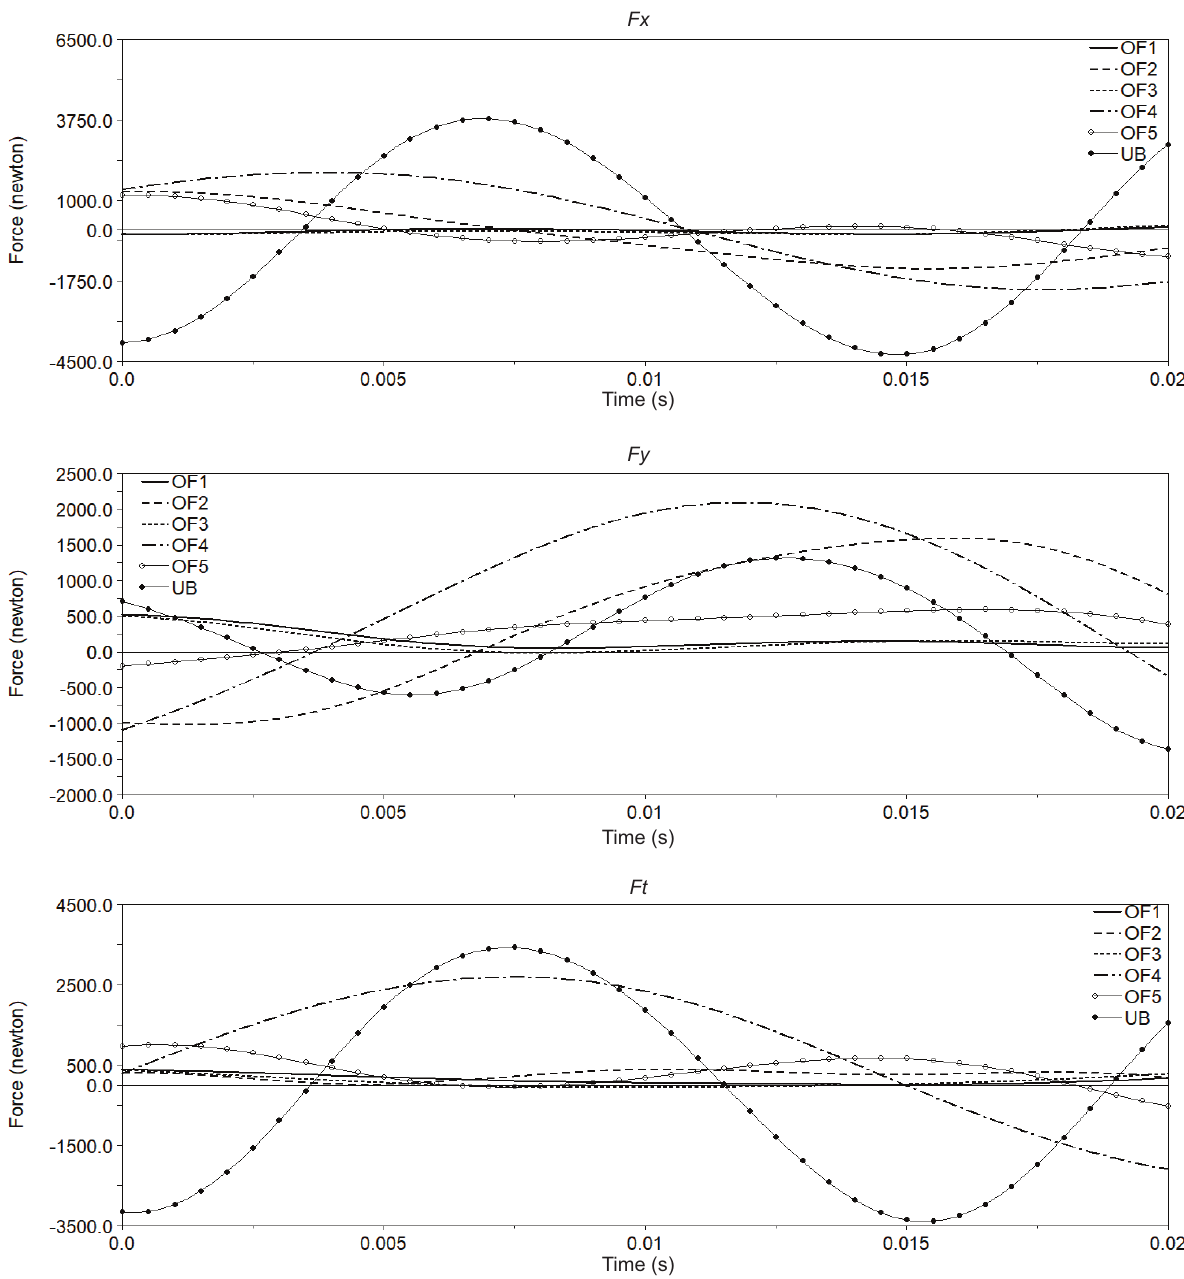
Fig. 4. Unbalanced (UB) and balanced shaking force components for the suggested